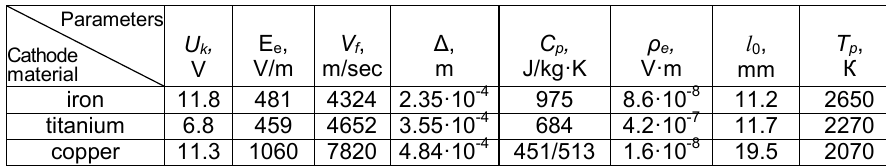
Table 1 – Main parameters of the double electrical layer Таблица 1 – Основные параметры двойного электрического